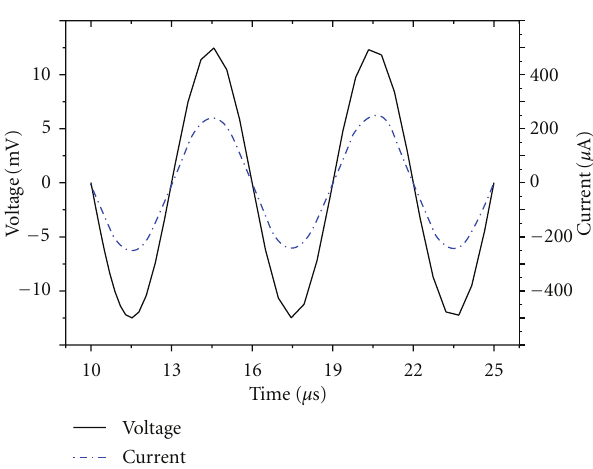
Figure 17: Transient response of inductor-nullifying